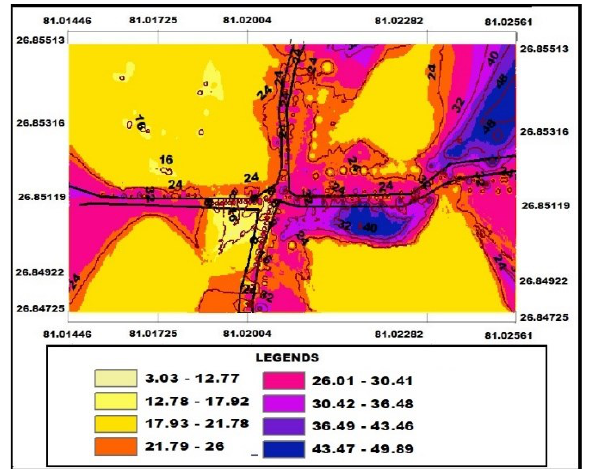
Figure 10. Noise level map of Haniman crossing showing the change in noise level of organized and unorganized traffic for afternoon time..